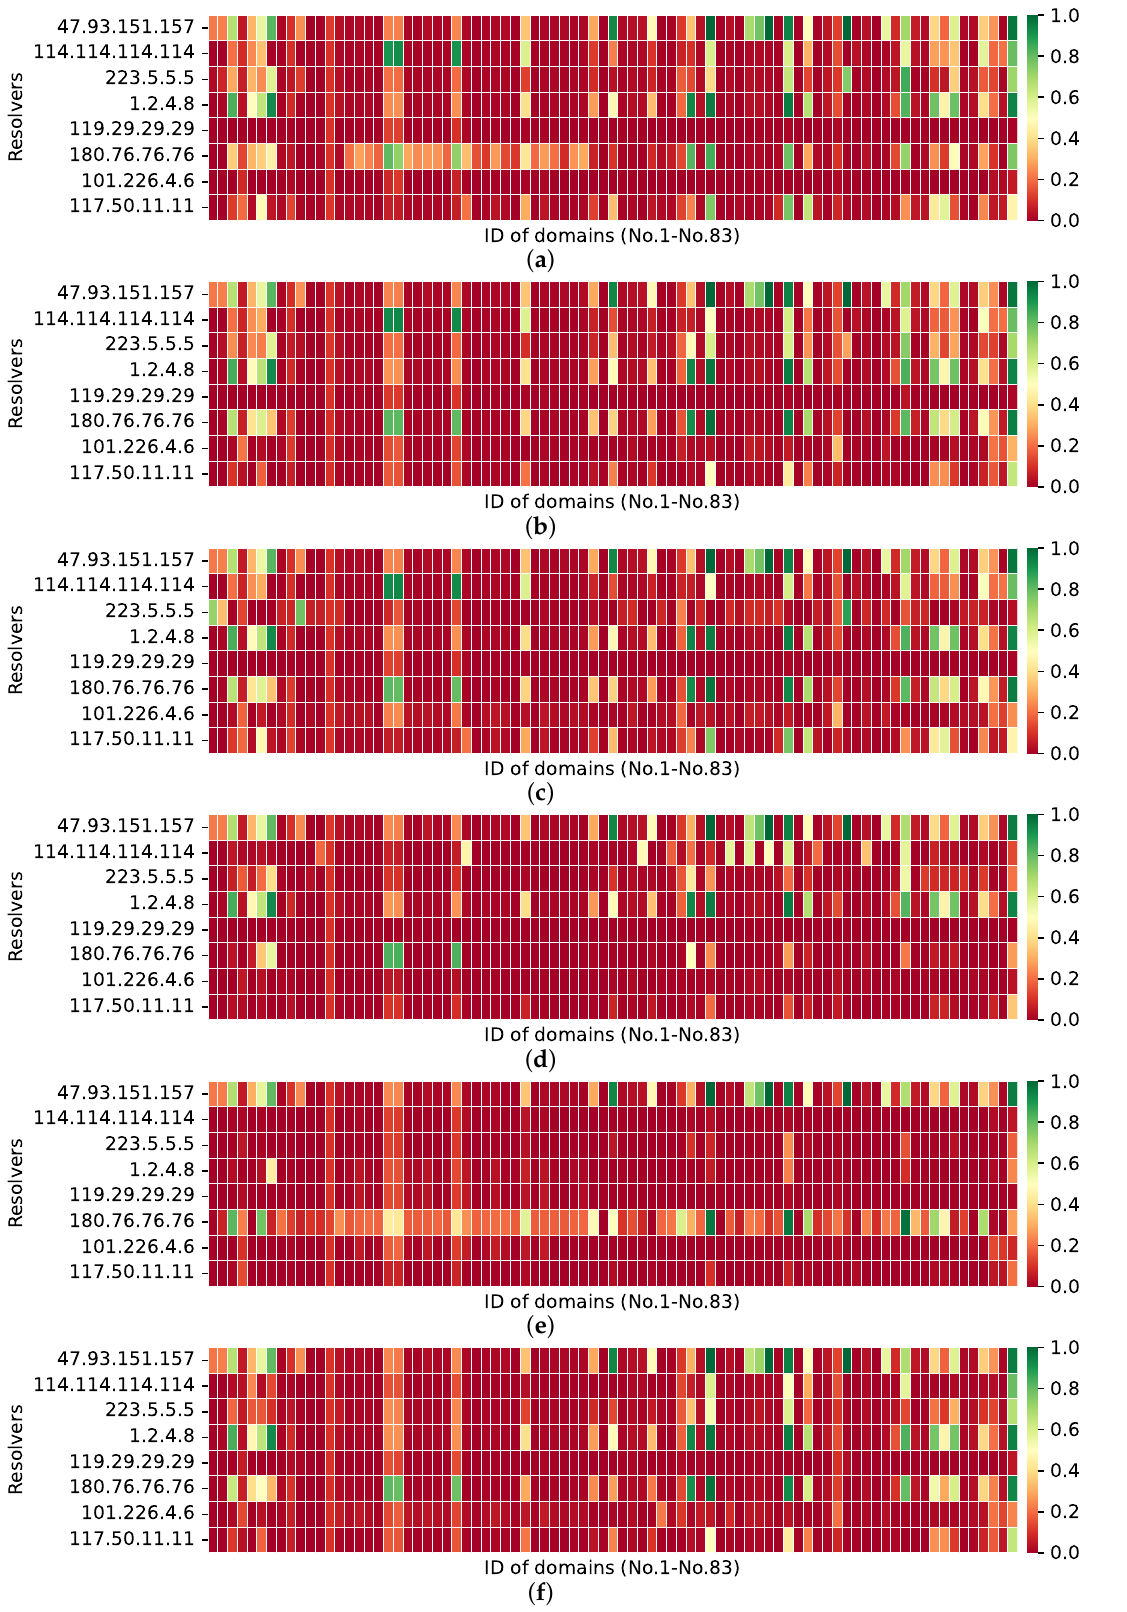
( f ) Figure 7. The ACR of each public resolver for blocked domains from different vantage points. ( a ) Beijing City, AliCloud; ( b ) Shanghai City, AliCloud; ( c ) Hebei Province, AliCloud; ( d ) Zhejiang Province, Mobile; ( e ) Zhejiang Province, Unicom; ( f ) Zhejiang Province,